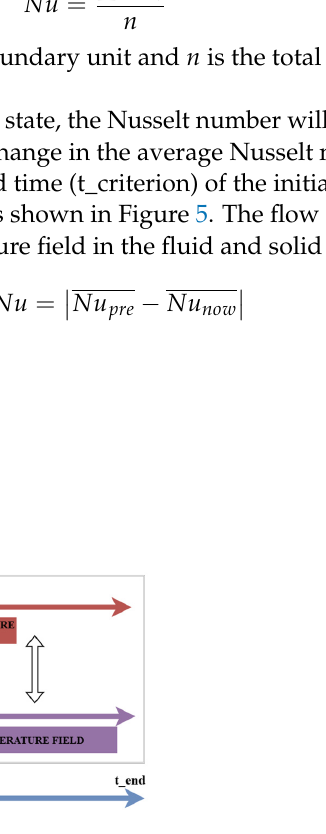
Figure 5. Flow chart of a novel optimization strategy using DeltNu as the flow field update end criterion.